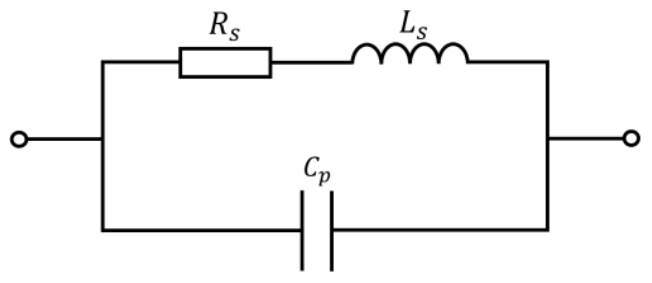
= 3.015 Ω, L = 3.507 μH, s s